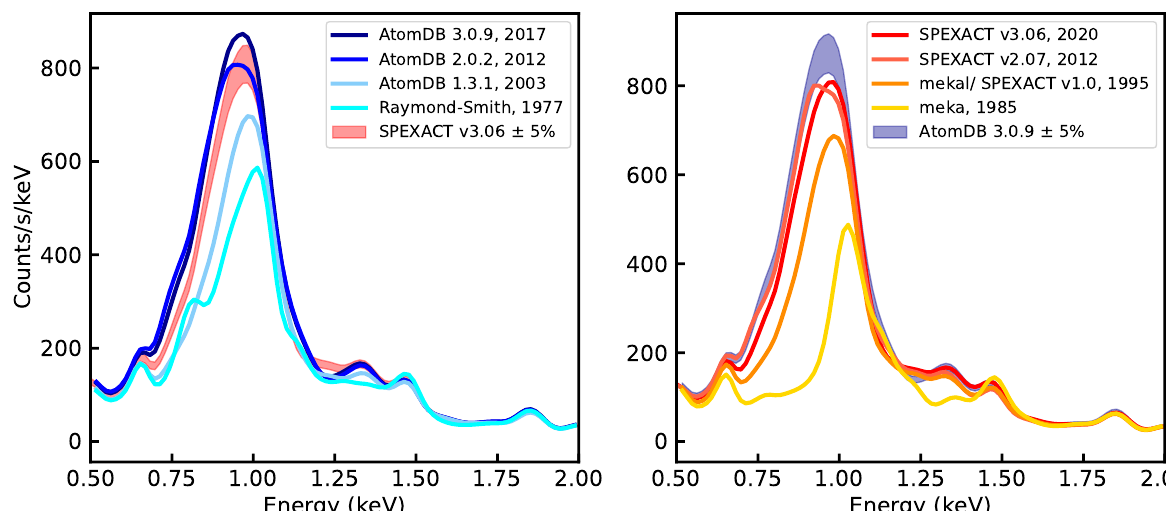
Figure 1. Historic evolution of the two most commonly used plasma emission models. For illustration, we focus on the specific case of a 1 keV plasma with Solar composition (following the Solar abundance units of Asplund et al. [43]). (cid:82) n e n H dV and have been folded through the XMM-Newton MOS detector All models have the same emission measure response. ( Left ) AtomDB [37] can be viewed as the replacement for/development of the Raymond-Smith code [44]. ( Right ) SPEXACT originated from the ’meka’ model developed by Rolf Mewe and Jelle Kaastra, which later became the ’mekal’ model; the addition of the final ’l’ comes from Duane Liedahl who calculated the atomic parameters for a large number of Fe L-shell ions